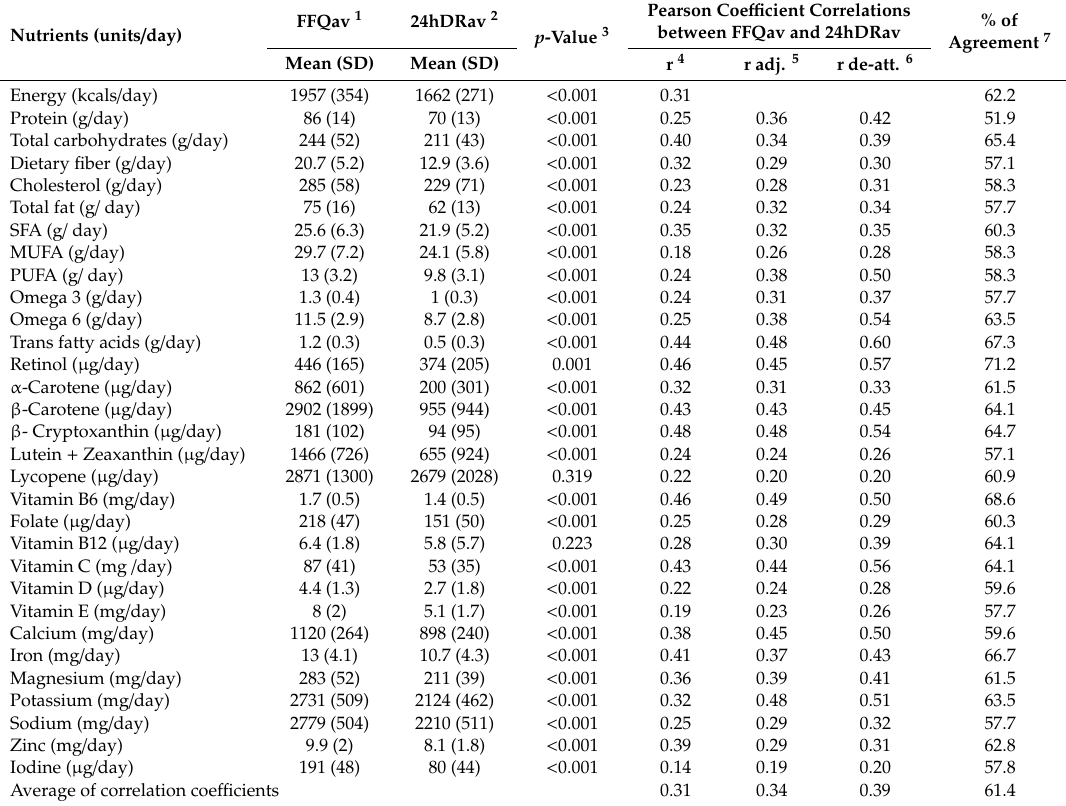
Table 5. Mean daily nutrient intakes and Pearson correlation coe ffi cients from the average of two FFQs and three 24hDRs among children aged 7–9 years of the INMA-Valencia study ( n = 156). Pearson Coe ffi cient Correlations % of FFQav 1 24hDRav 2 between FFQav and 24hDRav Nutrients (units / day) p -Value 3 Agreement 7 r adj. 5 r de-att.